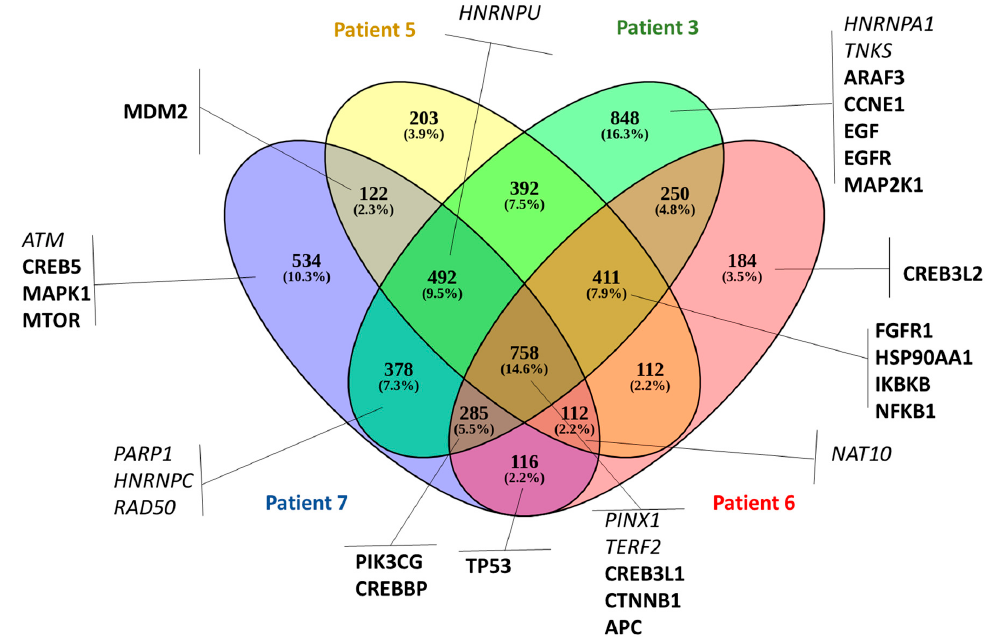
Figure 5. CTC-shared SNVs and indels for four prostate cancer patients. Venn diagram of genes with genetic variation within the coding sequence (frameshift indels and missense SNVs) in patient 3 (green), patient 5 (yellow), patient 6 (red), and patient 7 (blue). The genes highlighted in italic are from the GO term telomere maintenance (GO:0000723) and in bold from the KEGG related to prostate cancer (hsa05215).